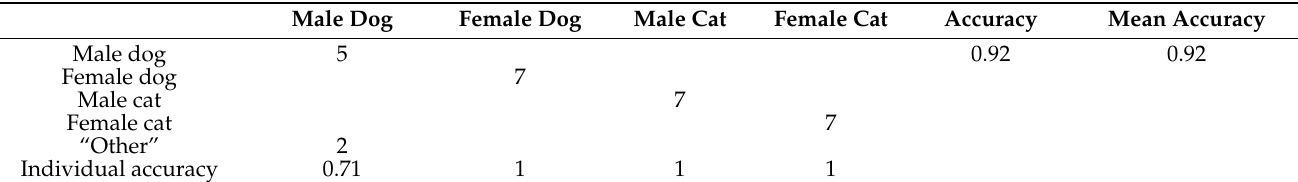
Table 17. The performance of Yolov4 majority voting on multi-classification under the balanced dataset.